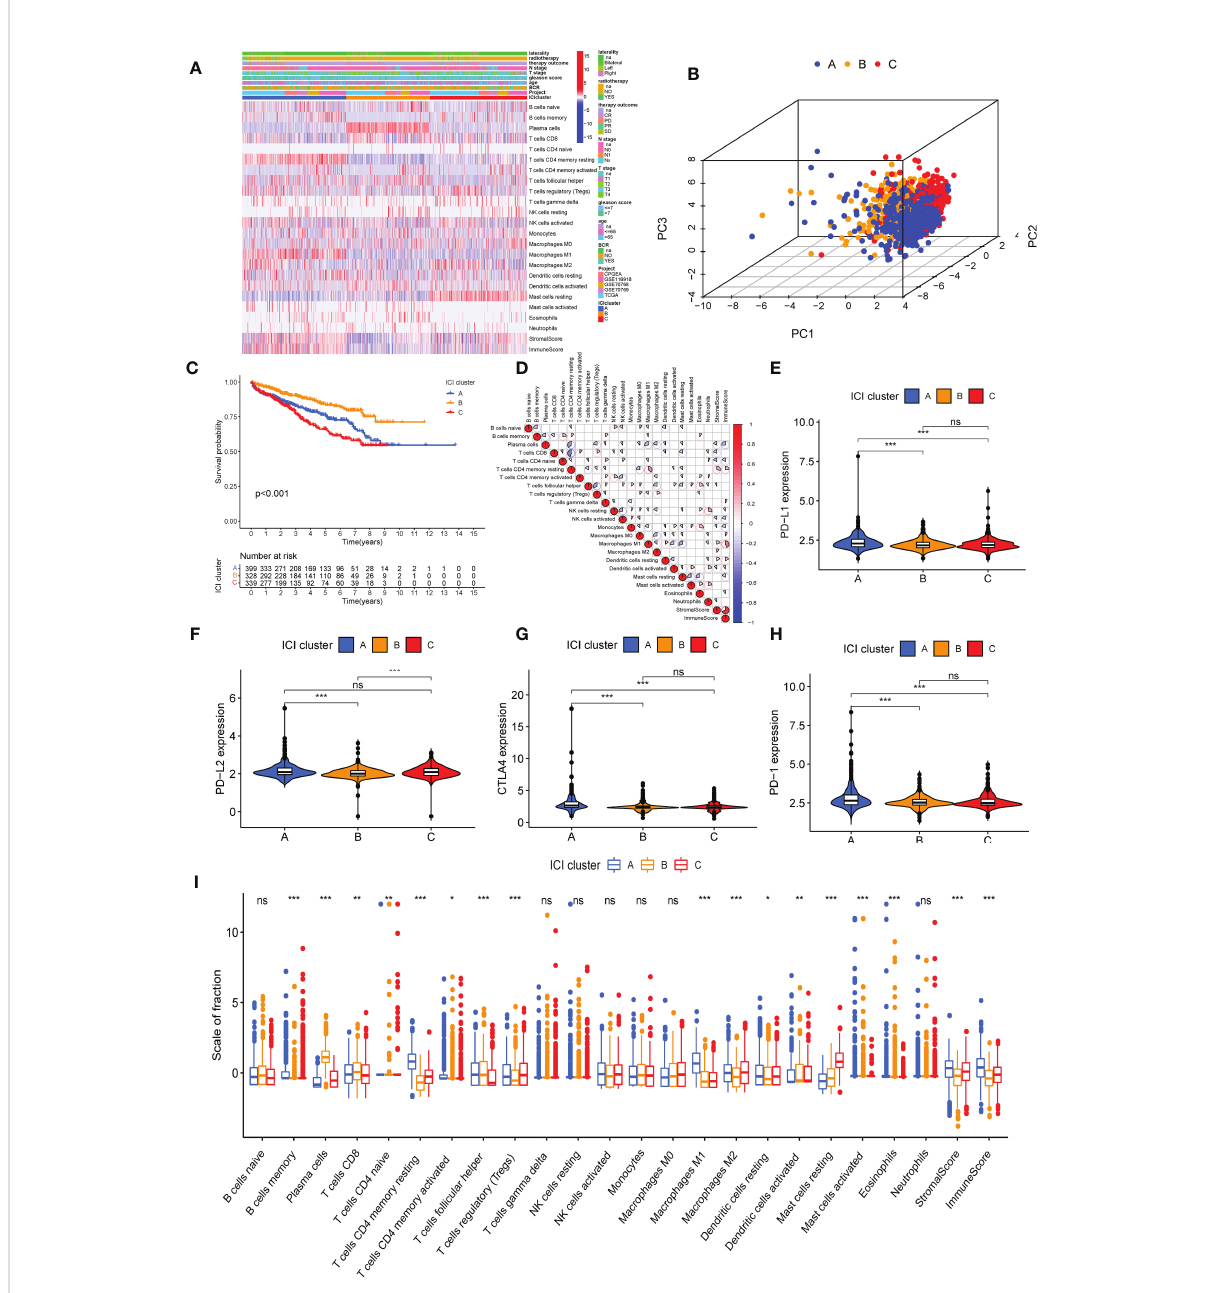
FIGURE 1 Immune cell in fi ltration (ICI) cluster subtypes of prostate cancer (PC). (A) The heat map shows the distribution of 22 immune cells, immune score, and stromal score in three distinct ICI cluster subtypes. (B) Three-dimensional diagram of principal component analysis of ICI clusters. (C) Kaplan – Meier curve was used to predict the biochemical recurrence-free survival of patients in four ICI clusters (log-rank test, P < 0.001). (D) Immune cellular correlation of the ICI score subtypes. Difference in the expression of PD-L1 (E) , PD-L2 (F) , PD-1 (G) , and CTLA4 (H) in patients in three ICI clusters. (I) Difference in the in fi ltration of 22 immune cells, immune score, and stromal score in three distinct ICI clusters. * P < 0.05, ** P < 0.01, *** P < 0.001. ns, no signi fi cance. CR, complete remission; PR, partial remission; SD, stable disease; PD, progressive